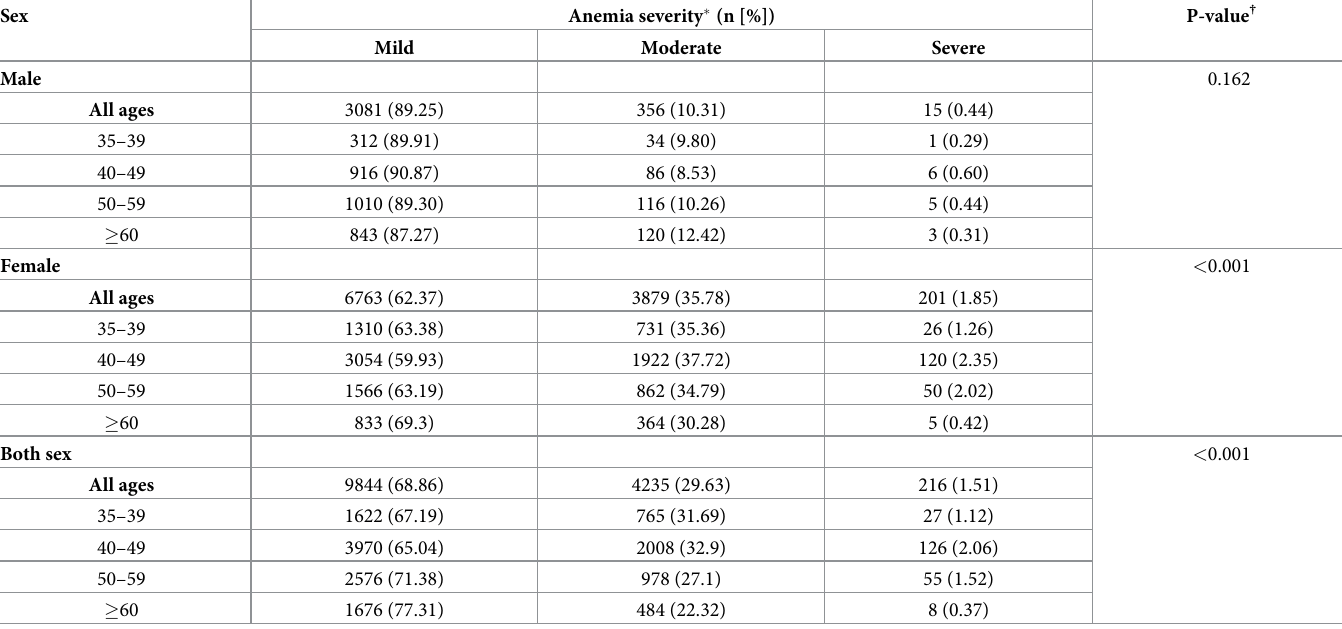
Table 5. Age-specific prevalence of different anemia severities by sex (n =